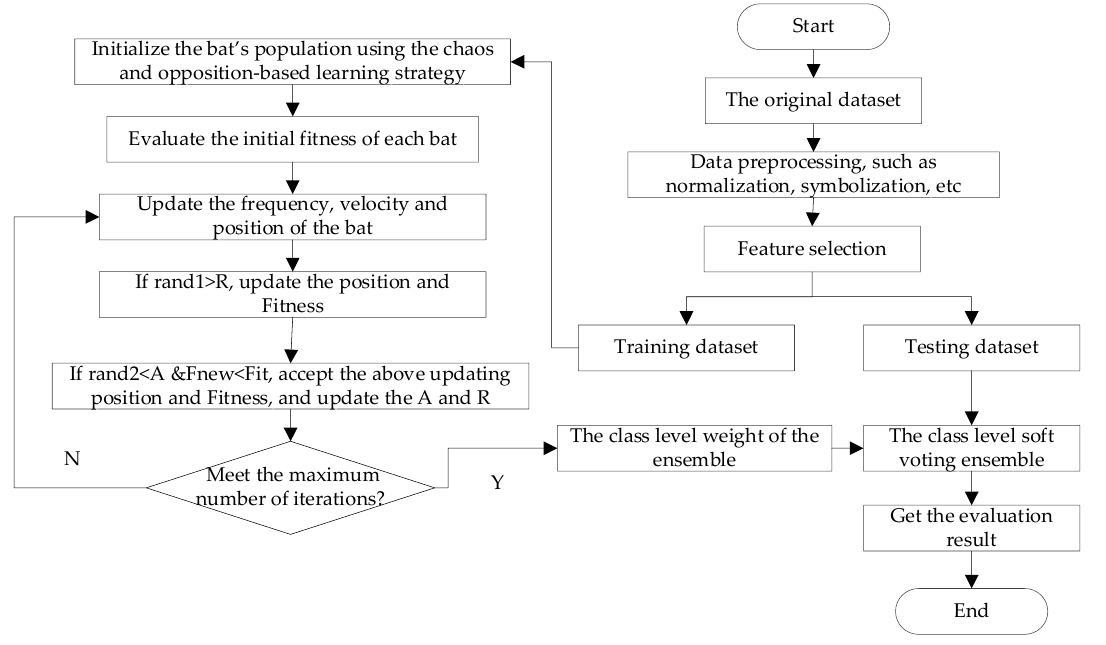
Figure 1. The flowchart of the CBA-CLSVE for intrusion detection.